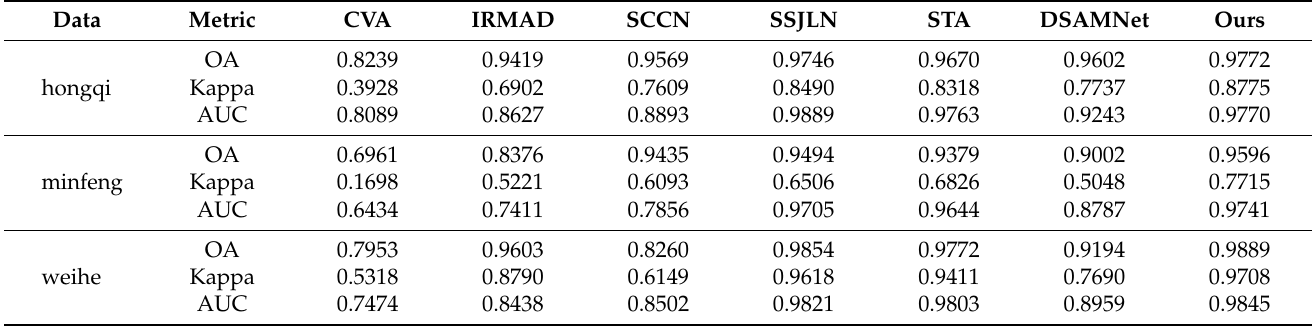
Table 3. OA, Kappa, and AUC values of different change-detection algorithms on different datasets.